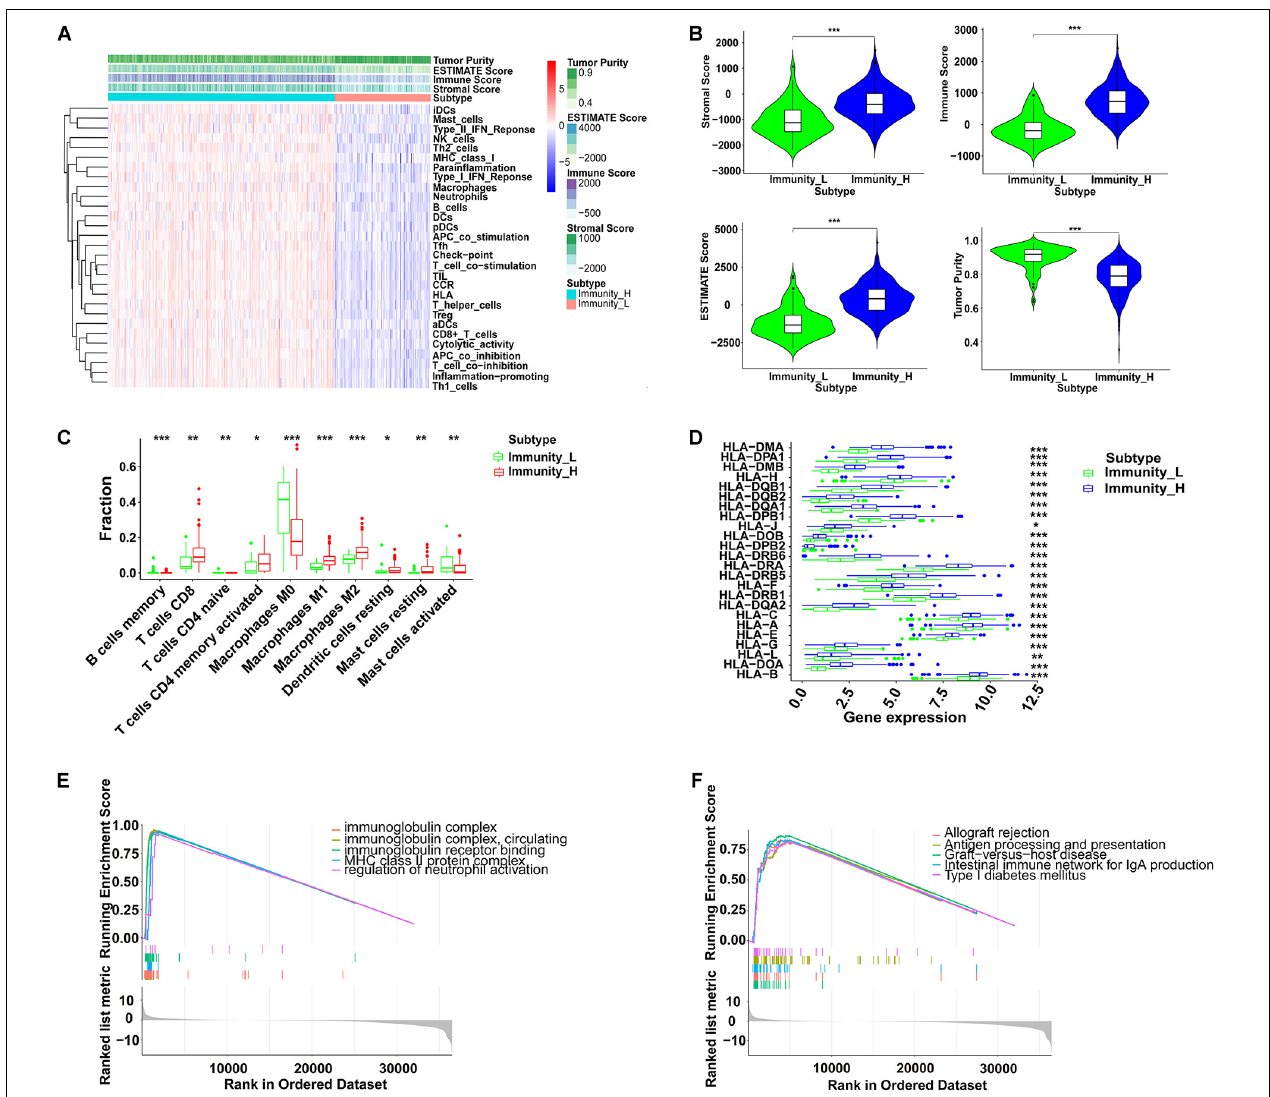
FIGURE 5 | Immunity profiles analysis in colon cancer. (A) By ssGSEA, immune related gene sets were enriched in different immunity groups. The tumor purity, ESTIMATE score, immune score, and stromal score were calculated and are shown in the heatmap. (B) The violin plots indicates that the high immunity group showed a significantly higher stromal score, immune score, and ESTIMATE score, but lower tumor purity (*** P < 0.001). (C) The fractions of 10 infiltrated immunocyte subtypes in different immunity groups (* P < 0.05, ** P < 0.01, *** P < 0.001). (D) The RNA expression levels of HLA related genes in different immunity groups (* P < 0.05, ** P < 0.01, *** P < 0.001). (E) GSEA of GO in different immunity groups. (F) GESA of KEGG in different immunity groups. ssGSEA, single sample gene set enrichment analysis; HLA, human leukocyte antigen; GO, gene ontology; KEGG, Kyoto Encyclopedia of Genes and